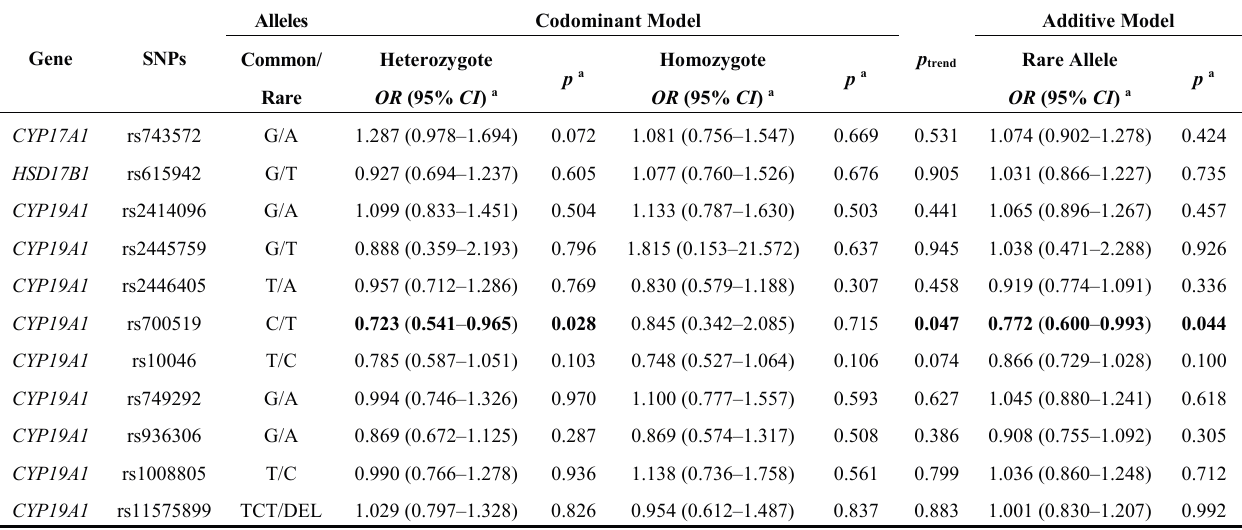
Table 2. Single single-nucleotide polymorphisms (SNPs) in estrogen biosynthesis genes and association with breast cancer.